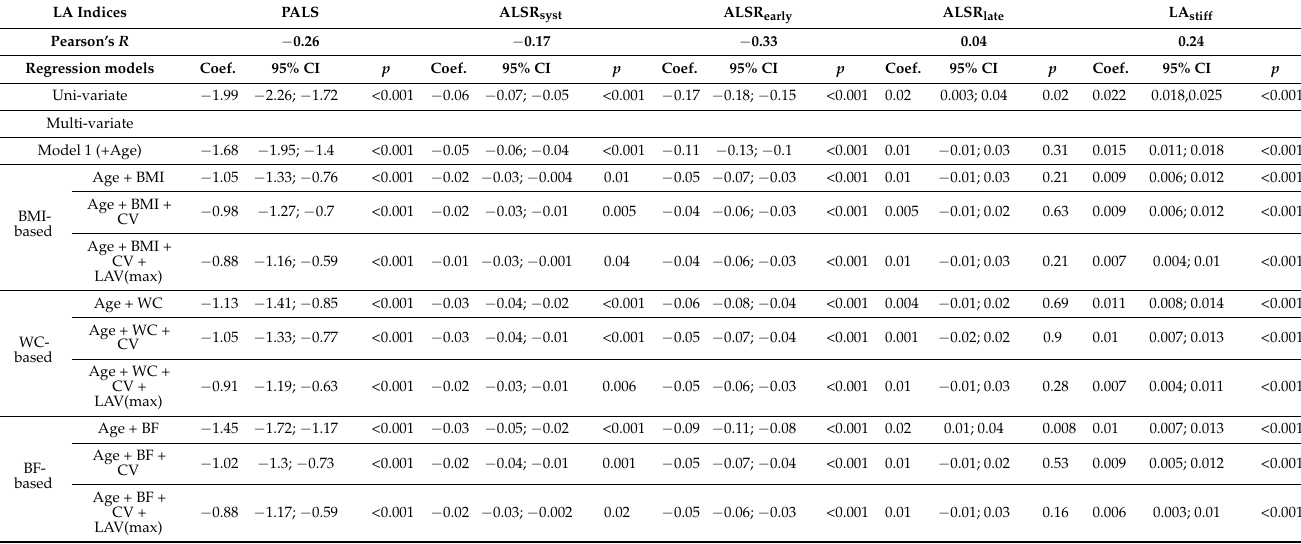
Table 4. Multivariate regression analysis of epicardial adipose tissue thickness (EAT) with atrial structure and